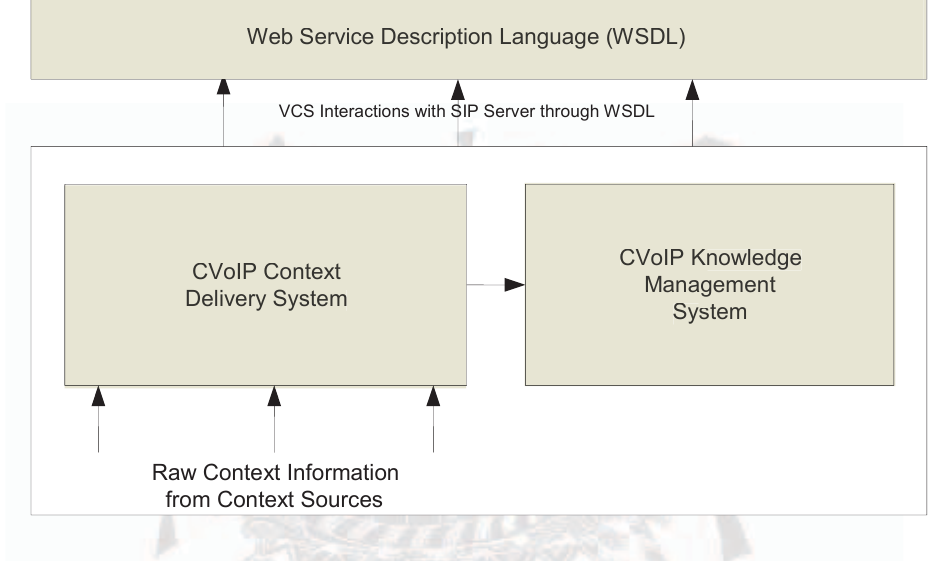
FIGURE 1: MAIN COMPONENTS OF VOIP CONGESTION CONTROL